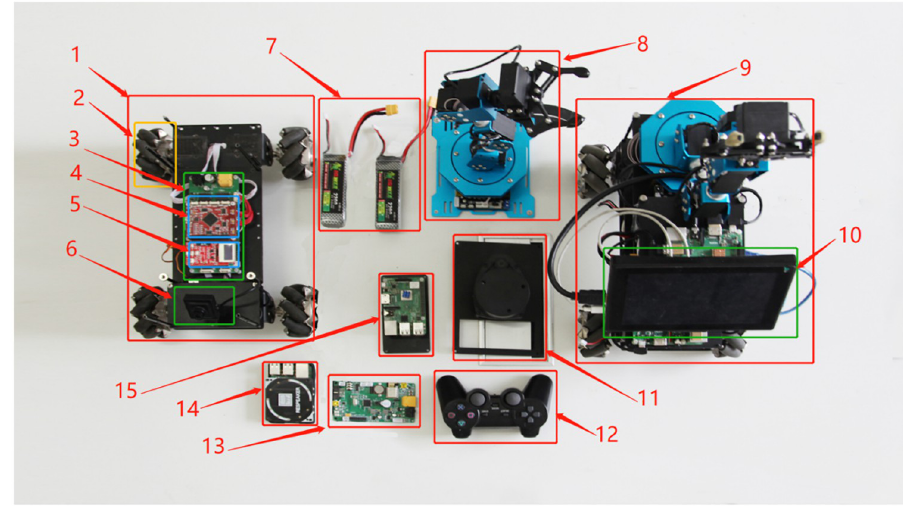
Fig 14. FS-AIROBOTB component